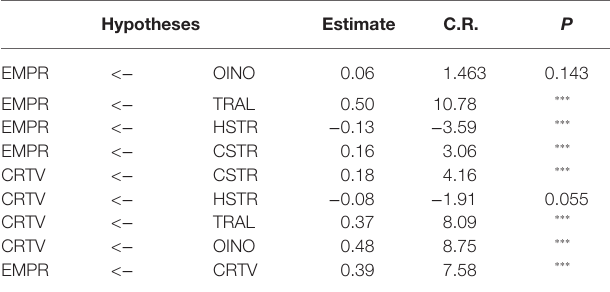
TABLE 4 | Results of hypothesis tests and model fitness index. Hypotheses